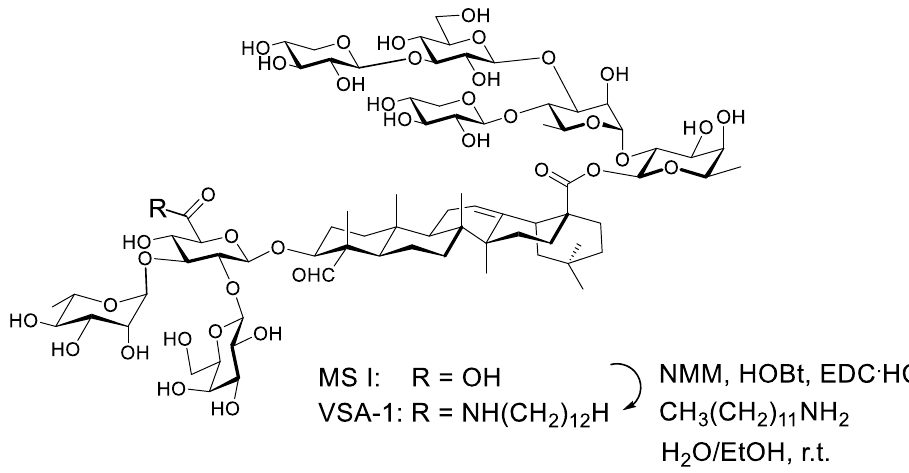
Figure 1. The structure of VSA-1 derived from Momordica saponin I, which was isolated from the seeds of Momordica cochinchinensis . Adapted with permission from Ref. [26]. Copyright © 2019, American Chemical Society.